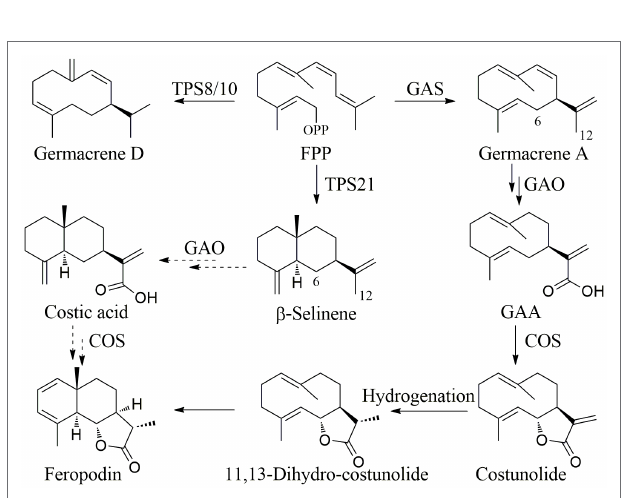
FIGURE 3 | Concentrations of major chemical compounds in A. nakaii EOs.